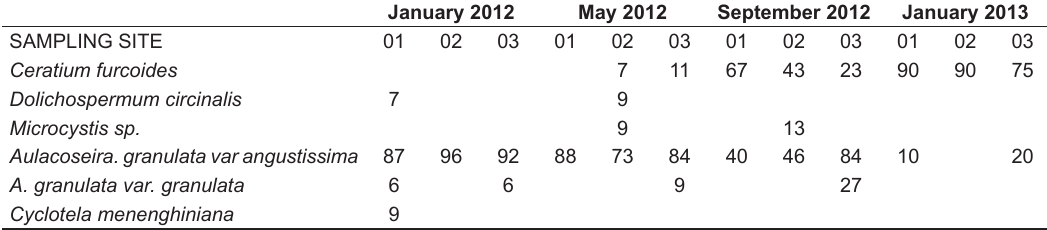
Table 2. Average percentage of biovolume referring to the three depths collected from the phytoplankton community in the Ernestina reservoir, RS.